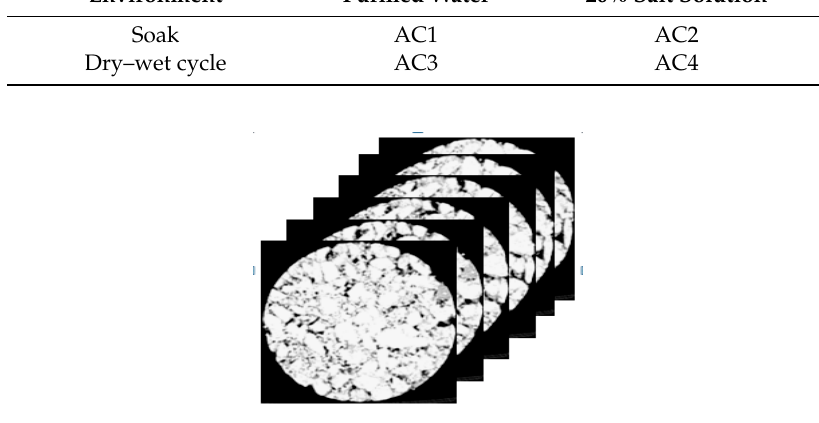
Figure 3. Scanned image overlay.